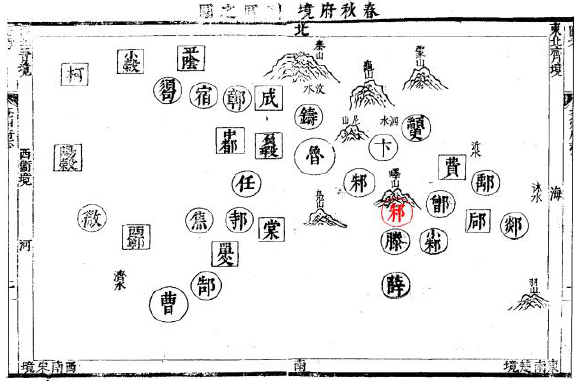
Figure 9. The Vassal States Map of Yanzhou in Spring and Autumn Period